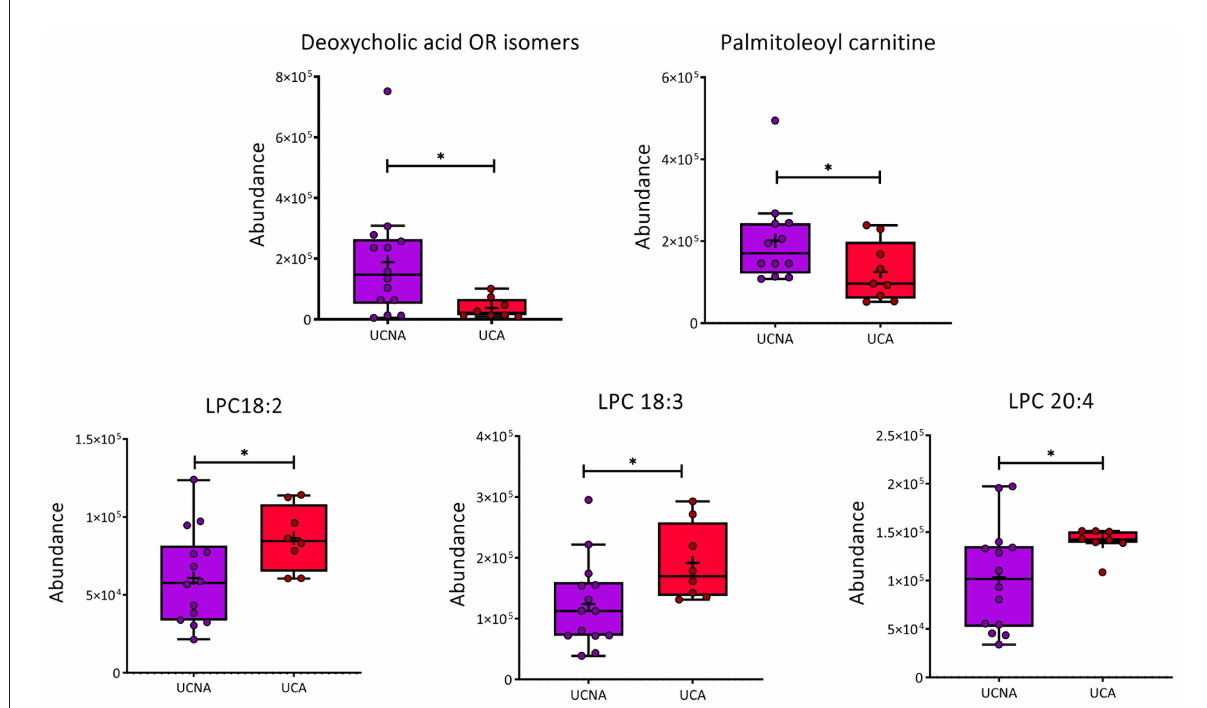
FIGURE4 Trajectories of relevant identified metabolites in box and whiskers plots between UCA (red) and UCNA (purple). Mean is represented by “ + ” inside the boxes, and individual data points are shown in dots. Mann–Witney U test was used to calculate significant differences. * p <